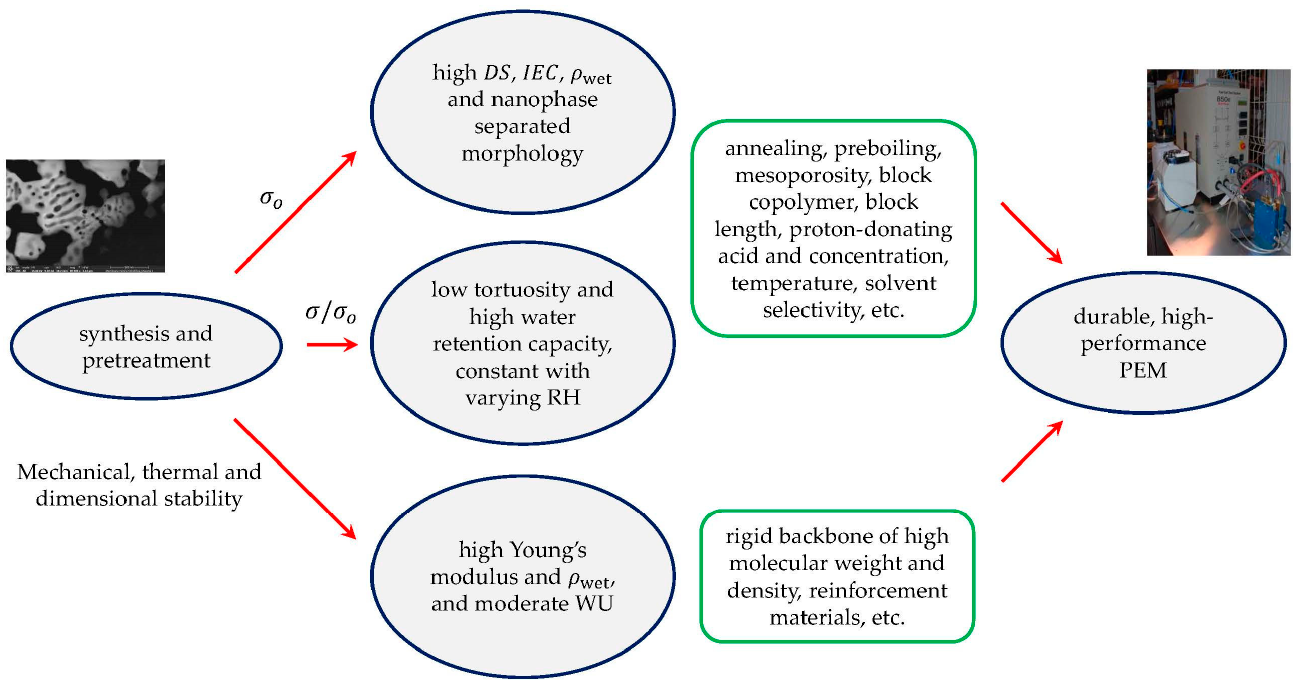
Figure 10. Flow chart showing key variablesand synthesis parameters for the design of durable, high-performance proton-exchange membranes (PEMs) extracted from the numerical model and experiments.